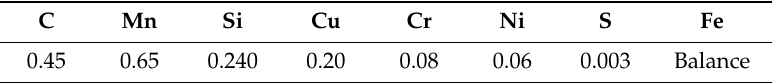
Table 1. Chemical composition of AISI 1045.